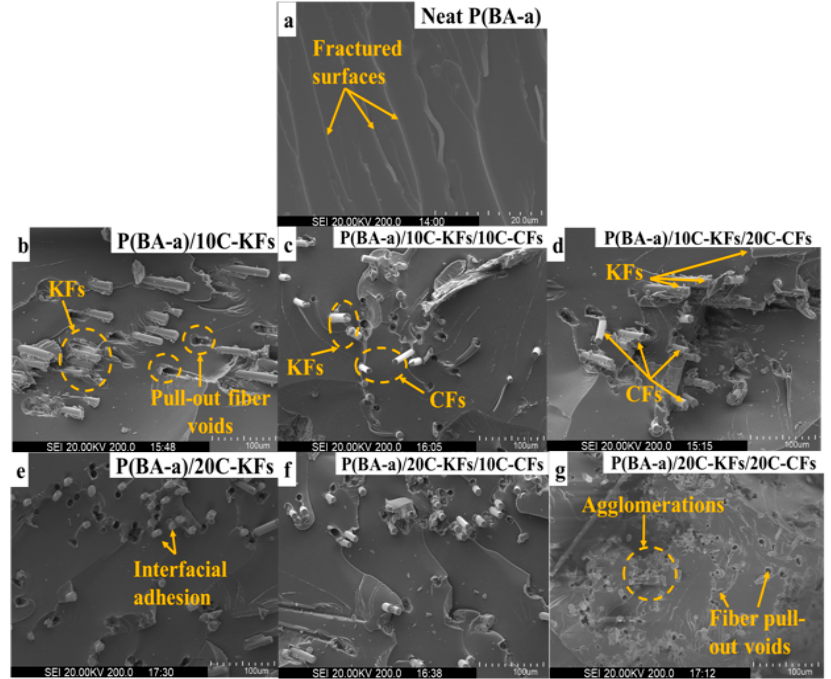
Figure 9. SEM micrographs of the hybrid benzoxazine composites.